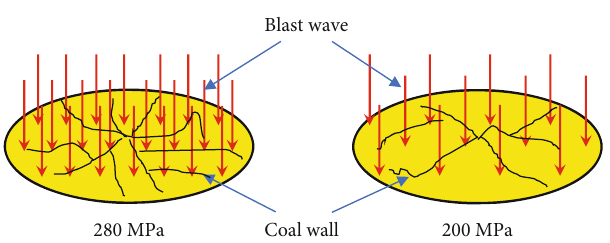
Figure 7: Diagram of coal body under di ff erent blasting pressures.